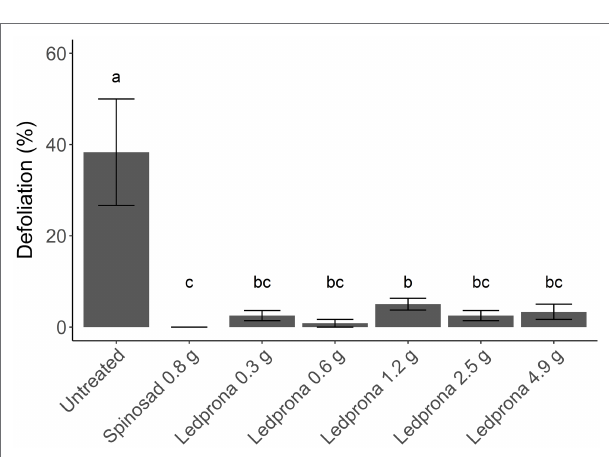
FIGURE 11 | Percent whole plant defoliation of potato plants by CPB larvae at 14 days after Ledprona treatment in a greenhouse trial. Bars represent the treatment means and error bars represent standard error of the means. Similar letters above the bars represent treatment means that do not significantly differ according to Tukey’s Honestly Significant Difference (HSD) test at value of p = 0.05. Rates are in g ai/ha.